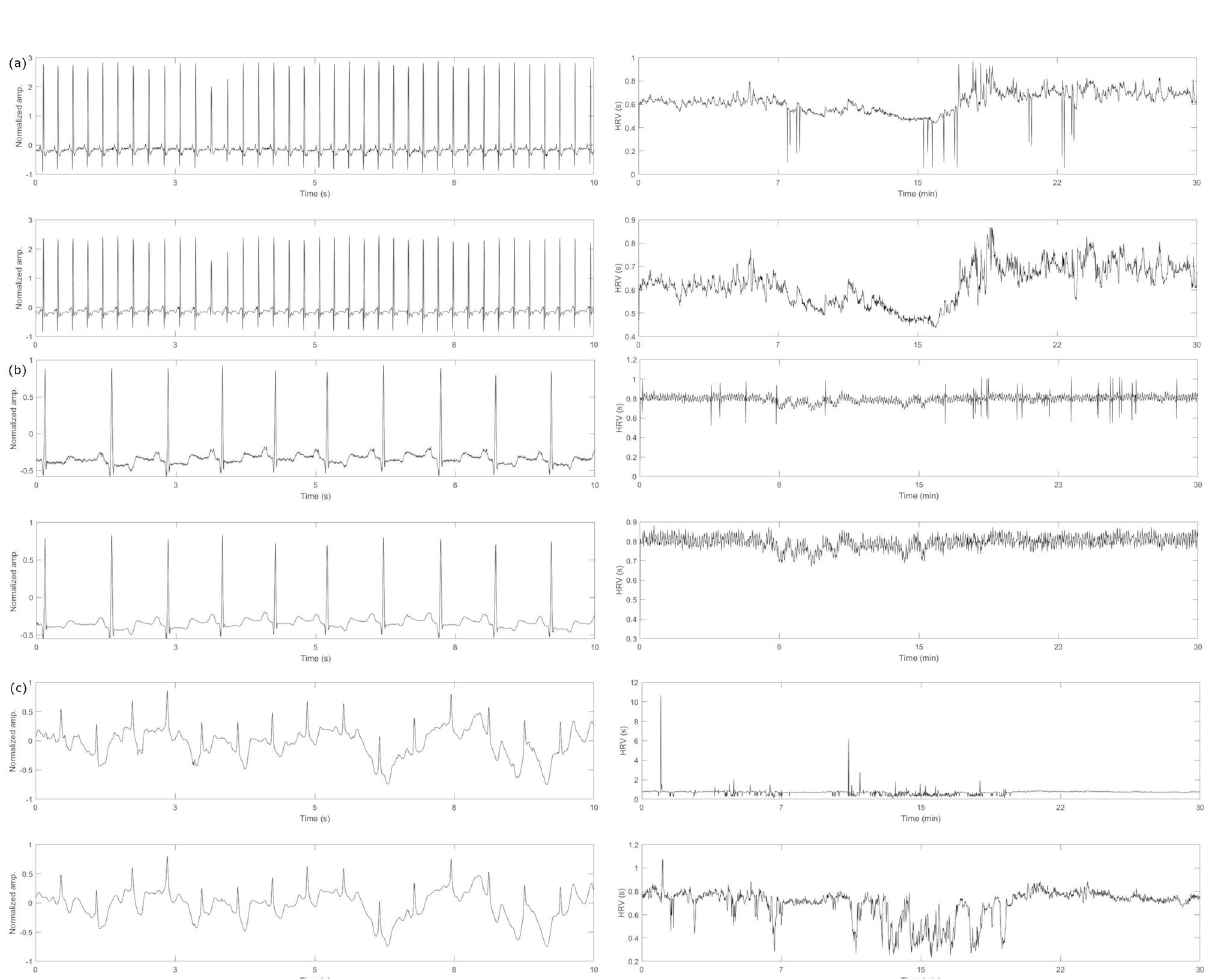
Figure 5. Proposed method applied to real ECG signals, ( a ) Denoising of the ‘16,539’ ECG recording from the MIT-BIH normal sinus rhythm database, CEEMDAN-WD filtering Gaussian noise (left), and SDROM- ADF filtering ectopic beats (right), ( b ) Denoising of the ‘119’ ECG recording from the MIT-BIH Arrhythmia database, CEEMDAN-WD filtering Gaussian noise (left) and SDROM-ADF filtering ectopic beats (right), ( c ) Denoising of the ‘52’ ECG recording from the sudden cardiac death database, CEEMDAN-WD filtering Gaussian noise (left) and SDROM-ADF filtering ectopic beats